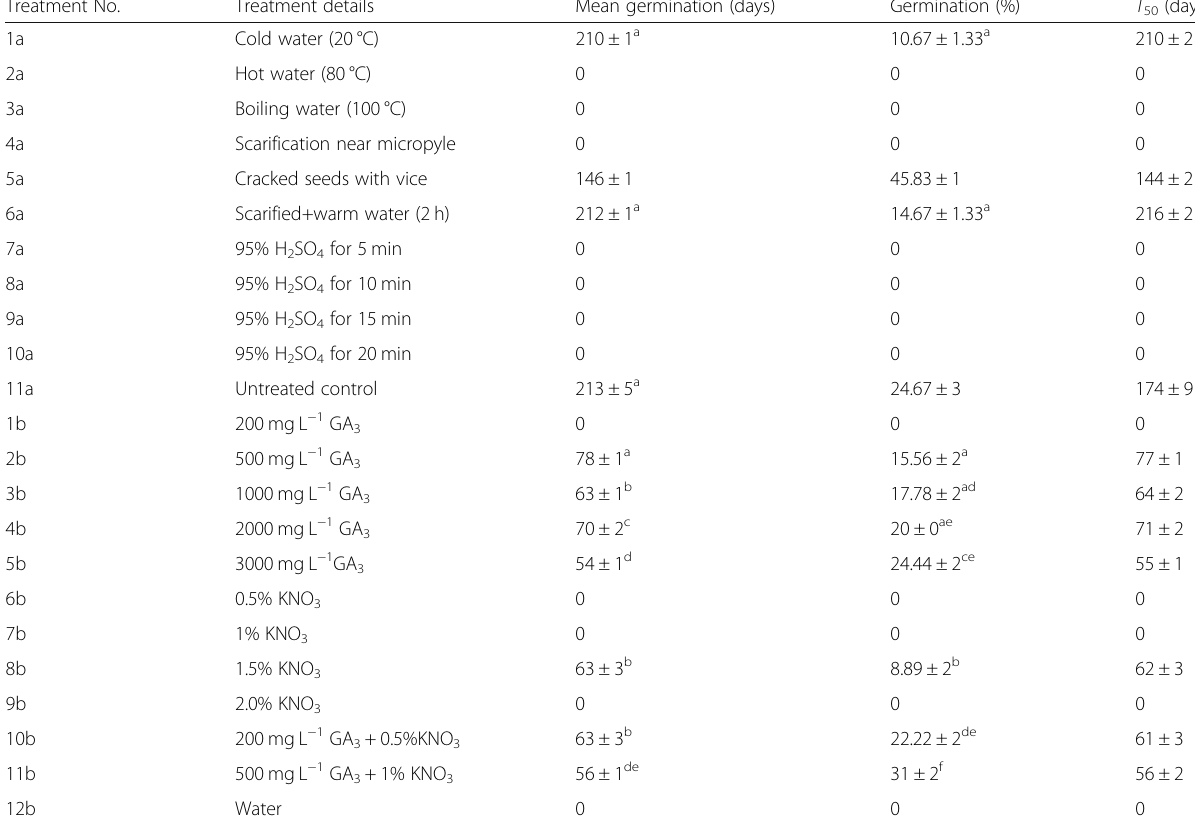
Table 2 Germination of E. prunifolius seeds subjected to (a) physical, mechanical and chemical scarification and (b) plant growth regulators Treatment